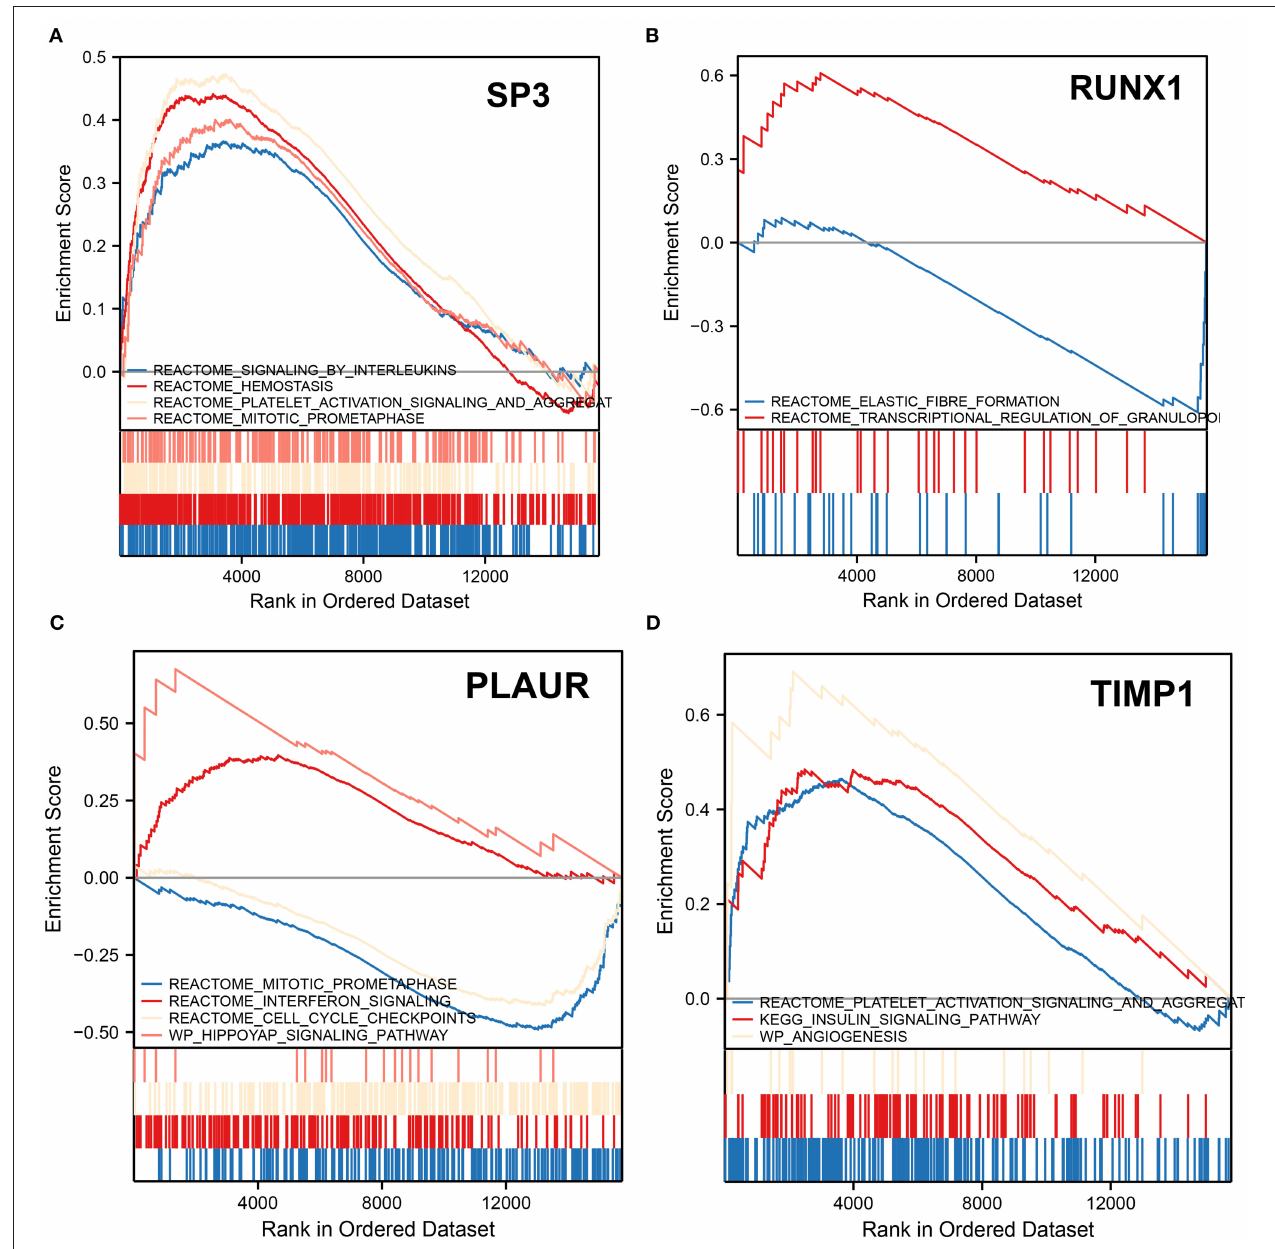
FIGURE 6 | Gene set enrichment analysis. (A) GSEA shows altered pathways in samples with downregulated SP3. (B) GSEA shows altered pathways in samples with upregulated RUNX1. (C) GSEA shows altered pathways in samples upregulated by PLAUR. (D) GSEA shows altered pathways in samples with TIMP1 upregulation. The upward peaks of the curve represent the upward adjustment pathway, while the downward peaks represent the downward adjustment pathway.